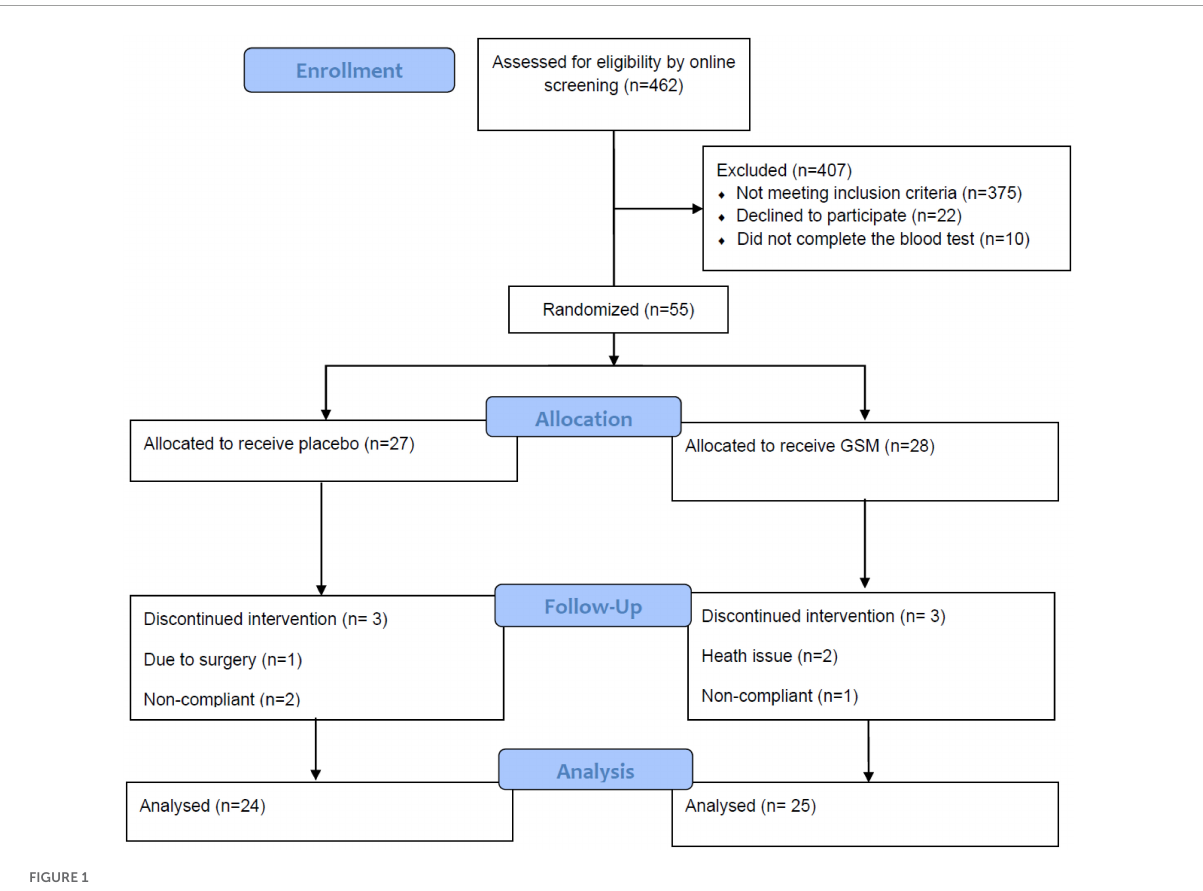
FIGURE1 Schematic diagram of study